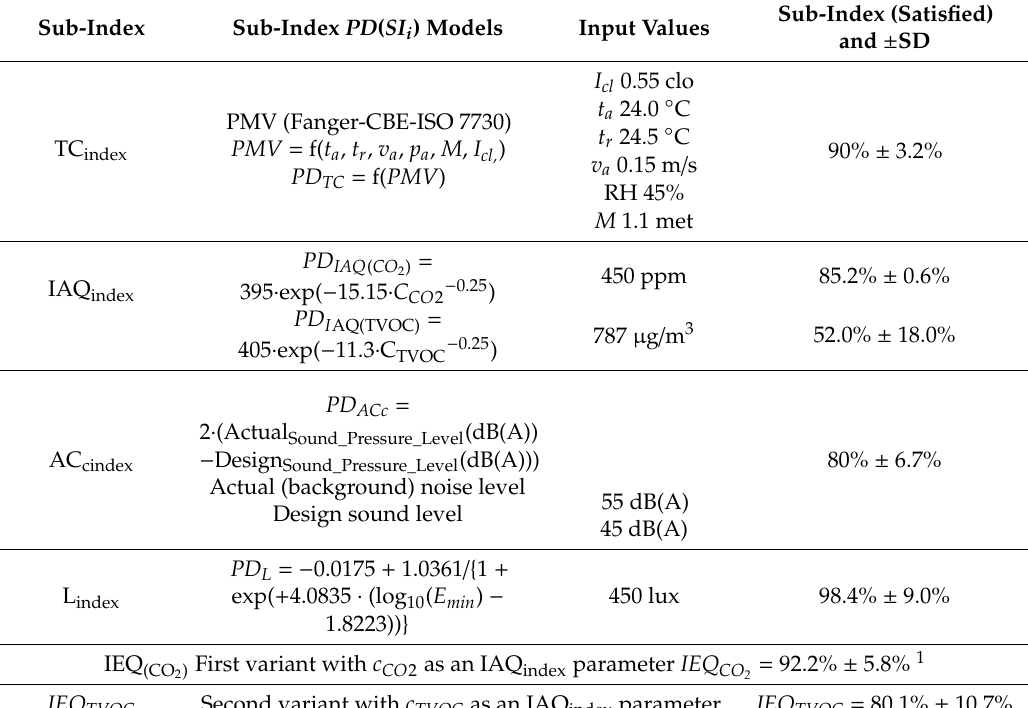
Table 5. Physical parameters 1 and IEQ index results calculated using Equation (9) separately for an IAQ index with internal air pollution of CO 2 and an IAQ index with internal TVOC air pollution, assuming a realistic uncertainty of parameter measurement for the case study of a building (47th floor; open space) three days after the completion of finishing